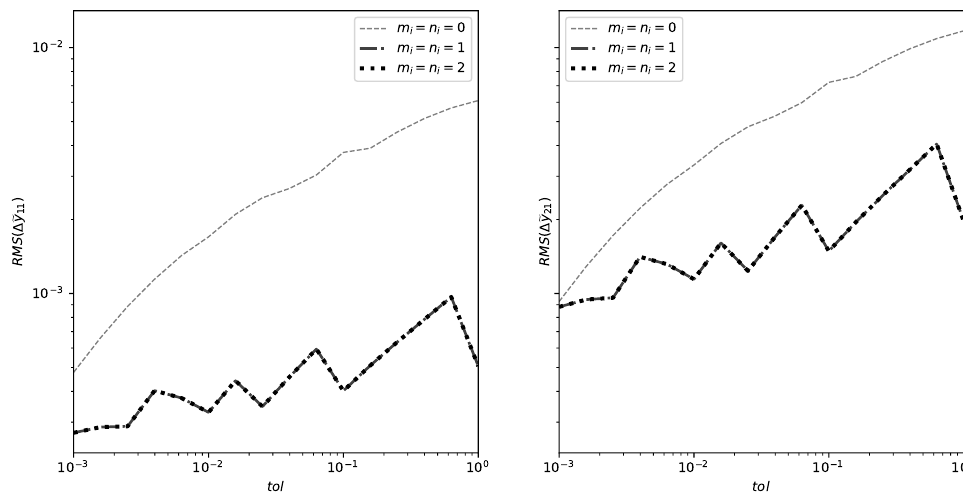
Figure 9. The diagrams show the numerical errors of the variable-step Jacobi co-simulation method (Algorithm 1, (39) and (50), H 1 = 10 − 4 ), different orders of interpolation polynomials and different internal subsystem